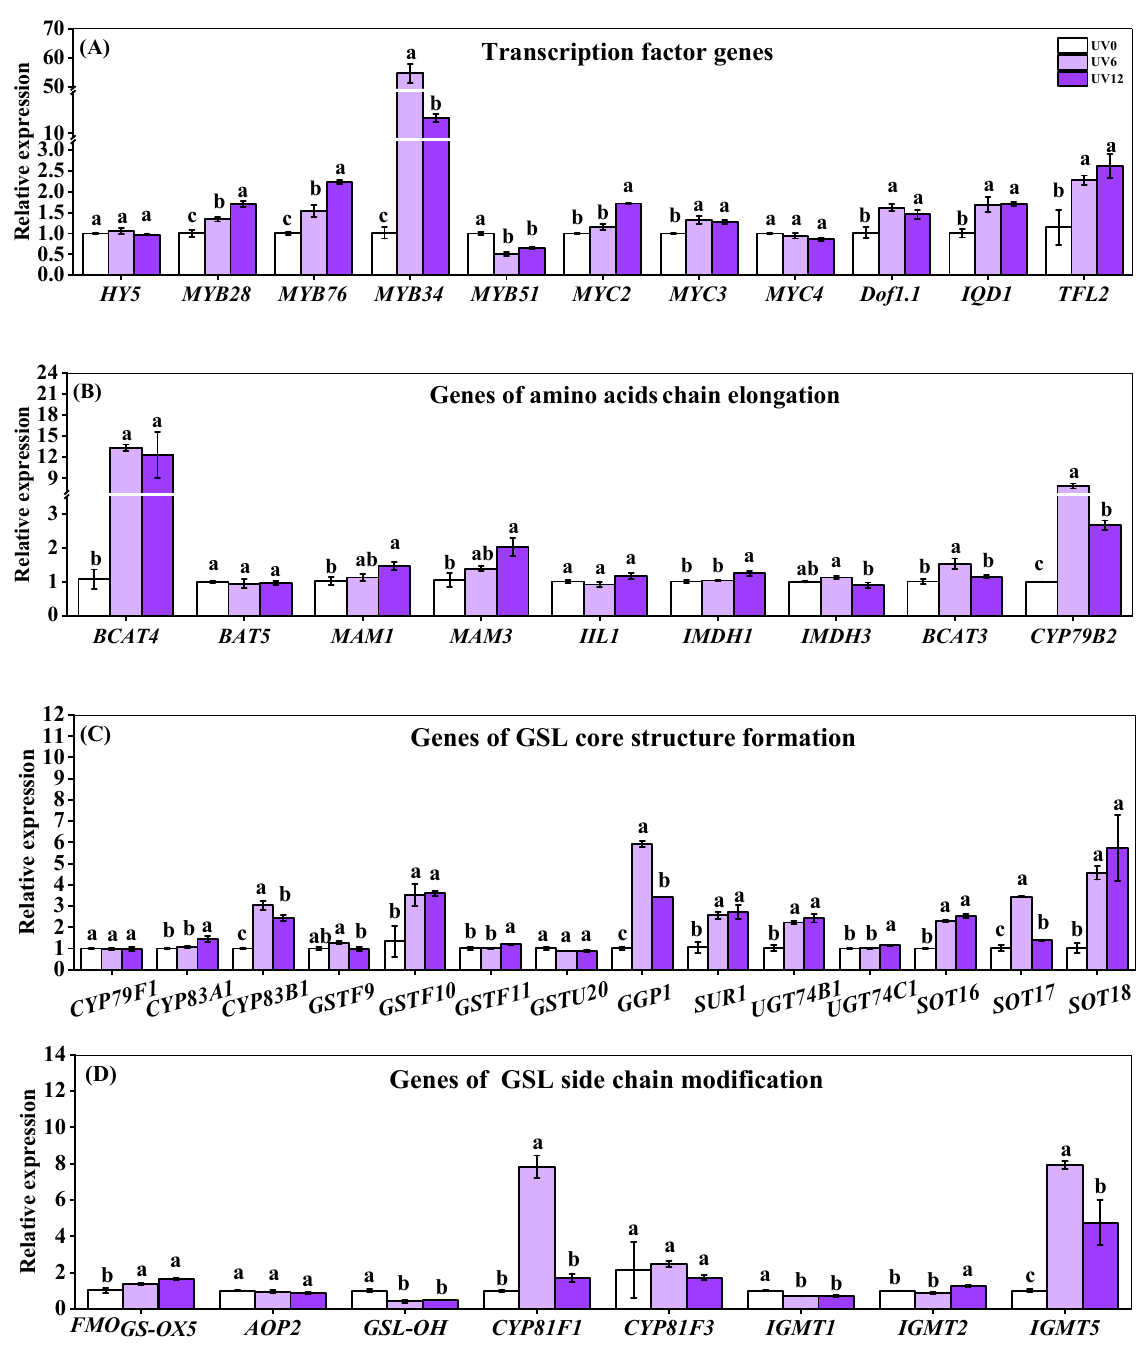
Figure 9. Expressions of genes of transcription factors and key enzymes related to GSL biosynthesis pathways of Chinese kale subjected to different durations of UVA-radiation exposure. ( A ) Transcription factor genes. ( B ) Genes of amino acid chain elongation. ( C ) Genes of GSL core structure formation. ( D ) Genes of GSL side-chain modification. Different lowercase letters (a–c) labeled on the vertical bar (means ± standard error, n = 3) represent significant differences by one-way ANOVA with multiple-range tests ( p ≤ 0.05).